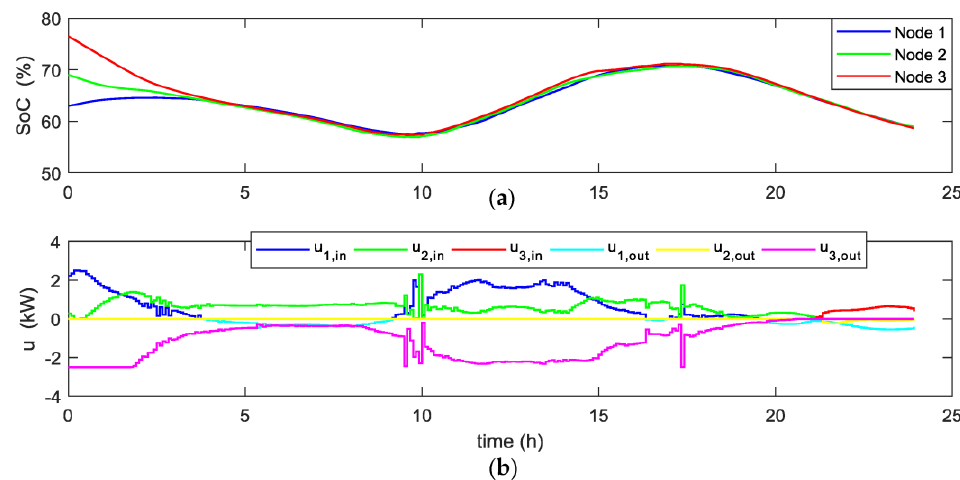
Figure 9. ( a ) Battery SOC at each node with NMPC enabled; ( b ) Control actions u applied at each time step at the DC/DC converters.